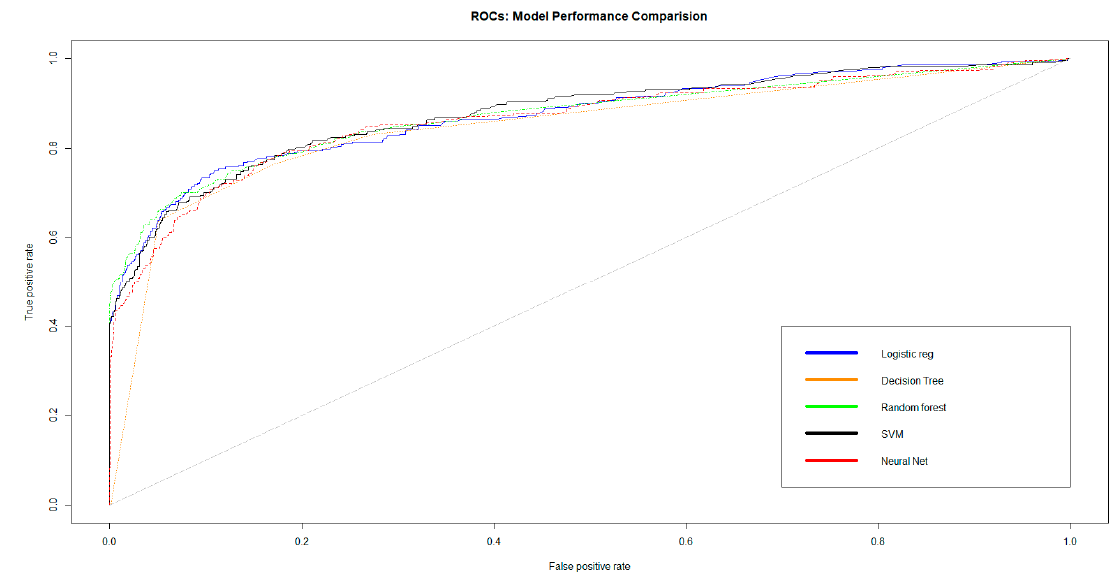
Figure 10. ROCs—model performance comparison for balanced training set with the synthetic minority oversampling technique (SMOTE) without scaling. Table 5. Performance evaluation metrics of models. Recall F1